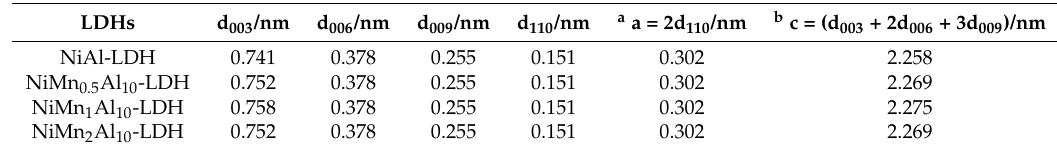
Figure 1. XRD results of LDHs precursors ( a ) and NiMn x Al 10 catalysts ( b ). The inset shows the displacement of the first diffraction peak (LDH-layered double hydroxide, C-catalyst). Table 1. Lattice parameters of the LDHs.